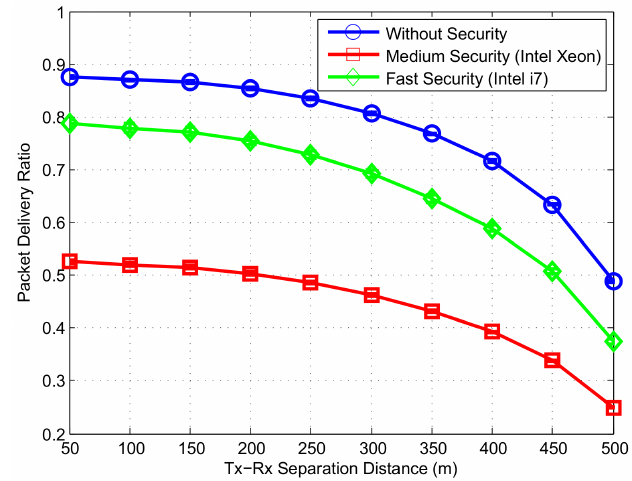
Figure 16. Packet Inter-arrival time at different levels of security.